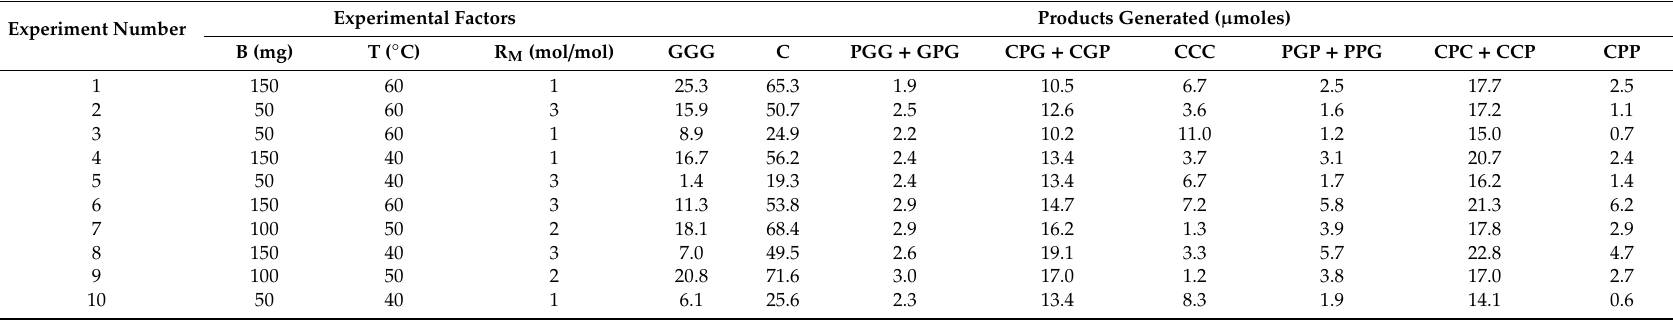
Table 3. Experimental factors and products generated during the enzymatic esterification of dicaprin with palmitic acid catalyzed by BCL / chitosan at 6 h of reaction. Experiment Number